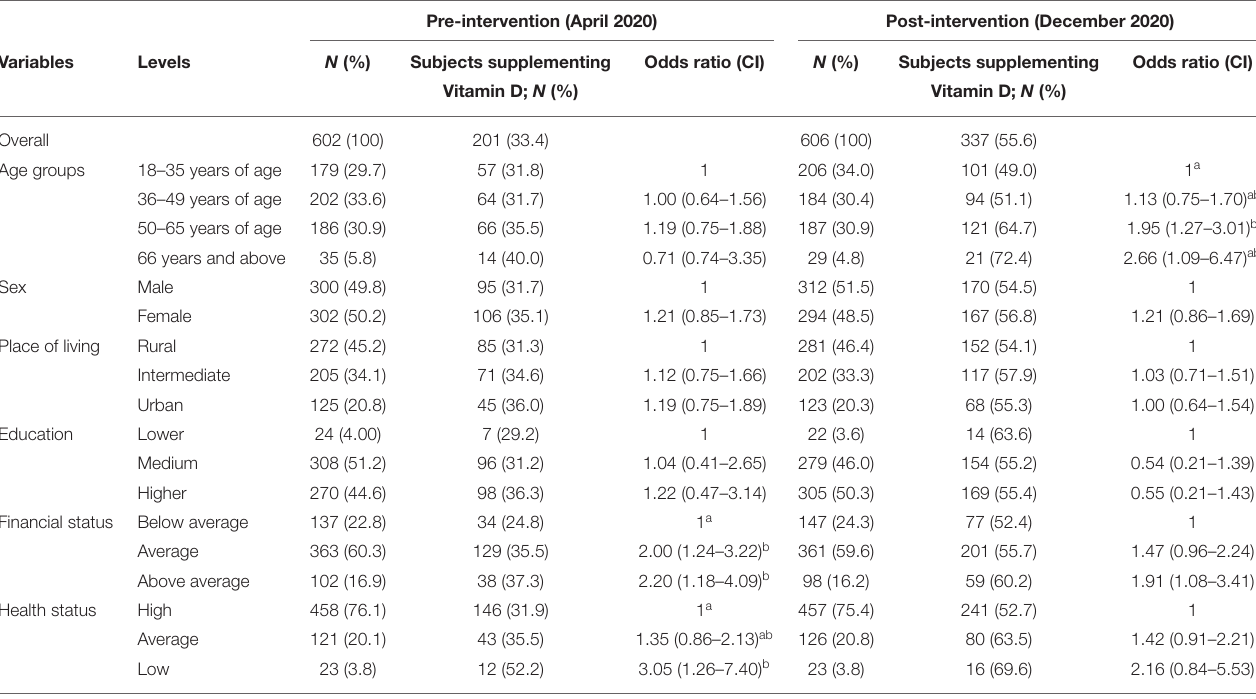
TABLE 6 | The proportion of the population using vitamin D supplements during COVID-19 pandemic by age, sex, place of living, education, financial status, and health status: pre-intervention (April 2020) and post-intervention (December 2020) data.